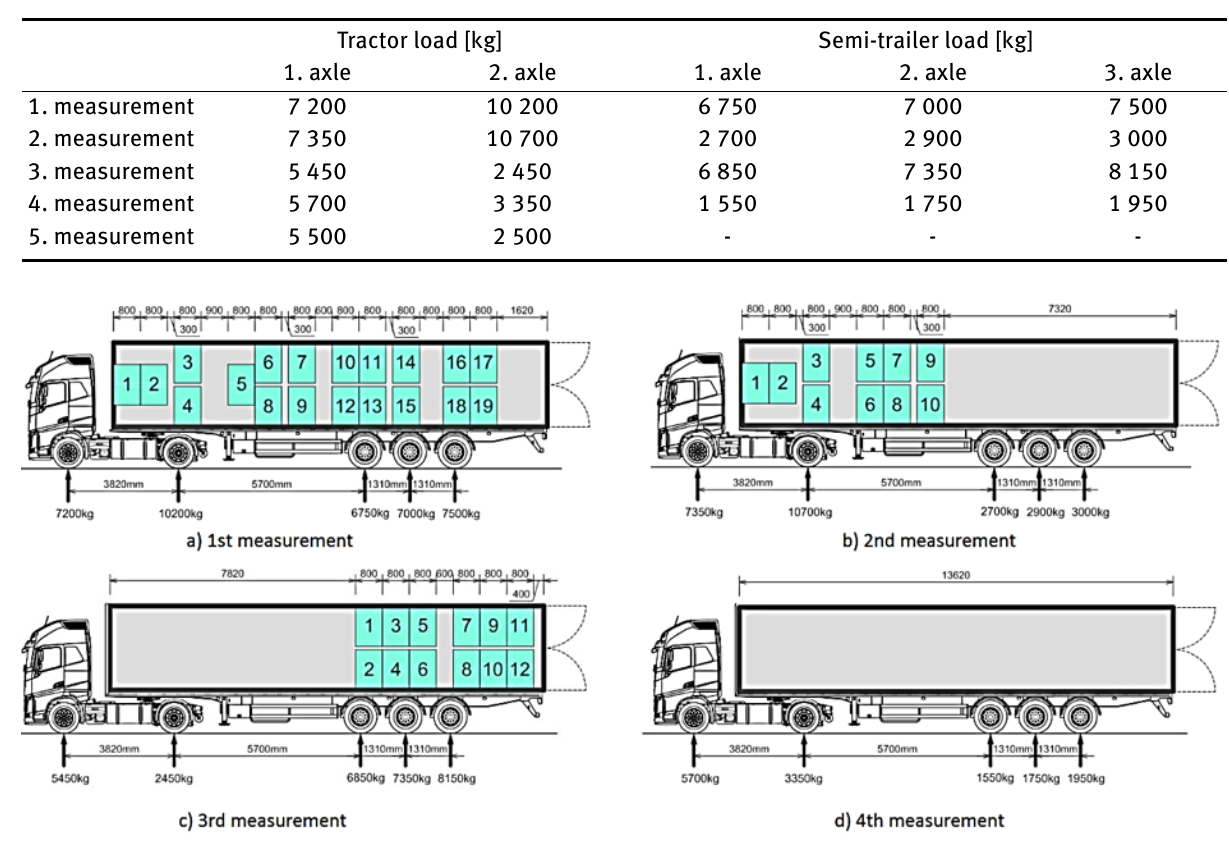
Table 2: The measured load of individual axles.